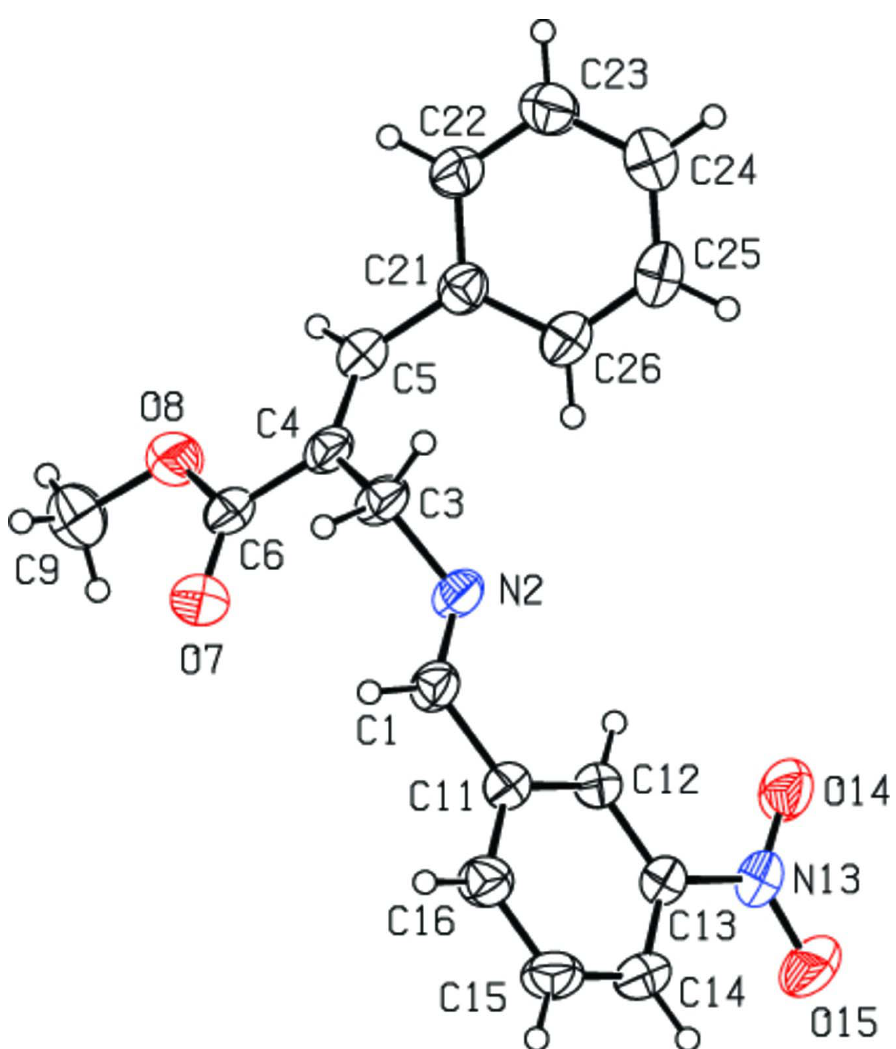
Figure 1 The molecular structure of the title compound with the labeling scheme. Displacement ellipsoids are shown at the 40% probability